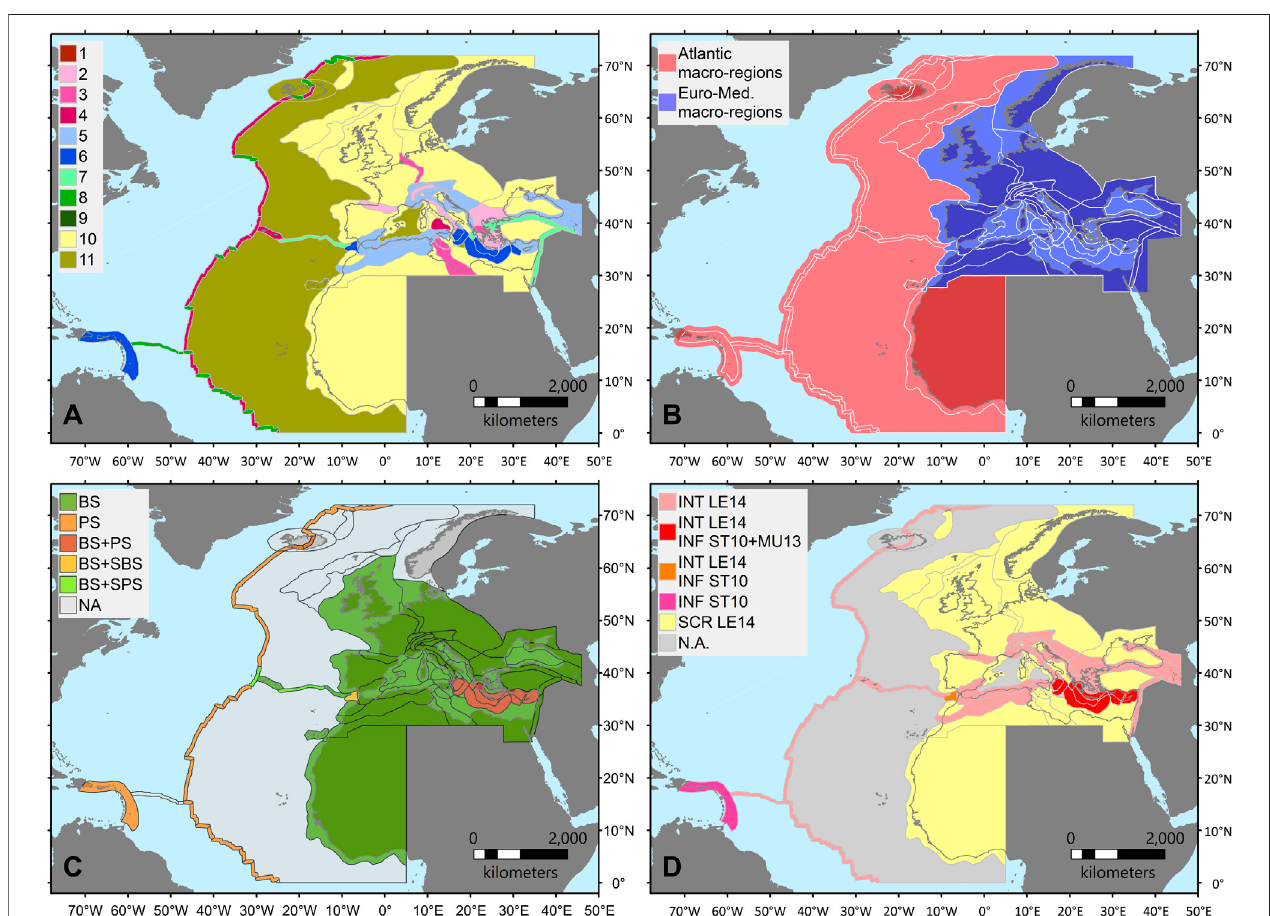
FIGURE 4 | (A) Map of the regions, color-coded depending on the tectonic setting and dominant deformation style, covering the whole source area. 1) Active volcano; 2) Back-arc and orogenic collapse; 3) Continental rift; 4) Oceanic rift; 5) Contractional wedge; 6) Accretionary wedge; 7) Conservative plate boundary (mainly majortranscurrentfaults);8)Transform faults.s.; 9)Shield;10)Stable continentalregion;11)Stableoceanicregion. (B) Map showingthemacro-regionsused toanalyze the completeness of the adopted earthquake catalogs (Supplementary Figure S2) . (C) Map showing the distribution of the seismicity model types assigned to each region of the tectonic regionalization. BS, background seismicity; PS, predominant seismicity; SPS, special PS; SBS, special BS; NA, not applied. (D) Map distribution of the adopted rupture scaling relations in the different tectonic settings. INT, interplate, crustal earthquakes; SCR, stable continental region, crustal earthquakes; INF, subduction interface. LE14 (Leonard, 2014); ST10 (Strasser et al., 2010); MU13 (Murotani et al., 2013); N.A, Not